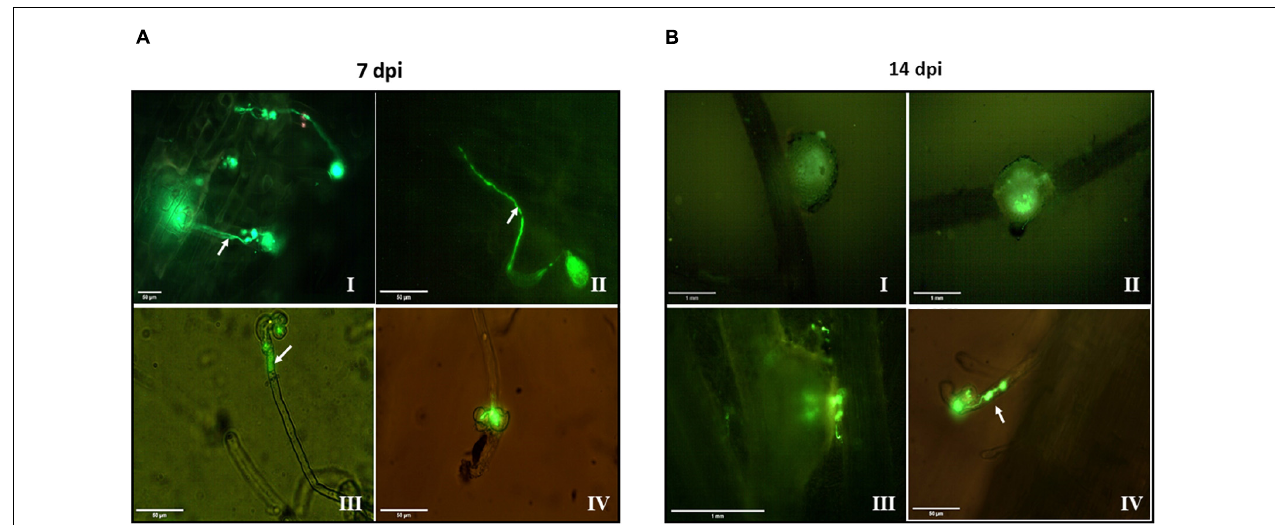
FIGURE 6 | Effect of temperature changes on the symbiotic behavior of Gfp -expressing S. meliloti with roots of Medicago sativa . Alfalfa roots of 7 (A) and 14 (B) dpi with Gfp -expressing S. meliloti grown under control conditions (I) and exposed to 10 ◦ C (II) , 40 ◦ C (III) , and 10 ◦ C (IV) . Arrows indicate infection threads generated by S. meliloti within root hairs. A culture of Gfp -expressing S. meliloti (200 mL) was grown to stationary phase at 28 ◦ C and then the thermal treatment applied (10 ◦ C–40 ◦ C–10 ◦ C). After exposure to each temperature for 24 h, an aliquot of 50 mL of culture was separated, centrifuged, and the biomass resuspended in physiological solution up to an CFU mL − 1 of 1 × 10 9 . Then an aliquot of that suspension (1 mL per plant) was used for inoculation tests. After 7 and 14 dpi, plants were removed, and the roots visualized in a fluorescence microscope at a 10 or 40 × magnification for nodules and infection thread respectively. Bars, 50 µ m for panels (A I–IV, B IV) , 1 mm for panels (B I–III)